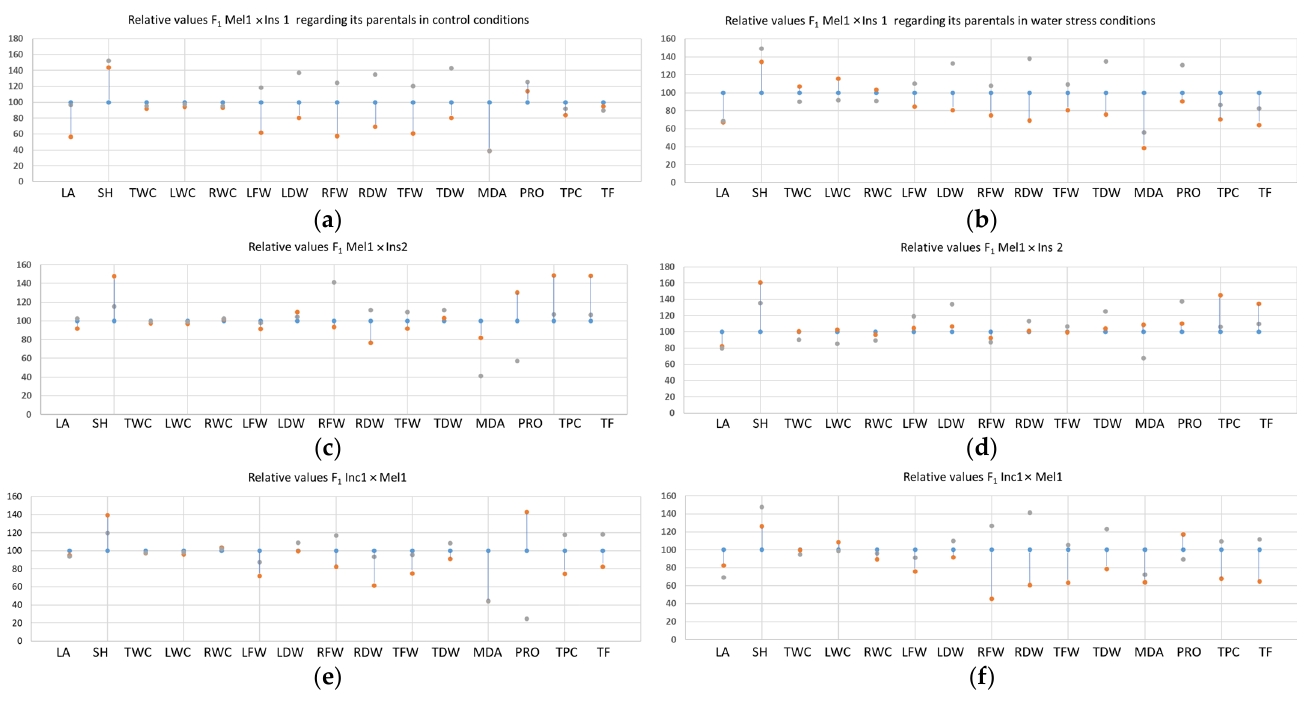
Figure 4. F1 relative values of MEL1 × INS1 in control ( a ) and under water stress ( b ); MEL1 × INS2 in control ( c ) and under water stress ( d ); INC1 × MEL1 in control ( e ) and under water stress ( f ). For each parameter, the MEL1 value was taken as a reference (100%), and the other values were referred to it. To clearly visualise superdominant or transgressive effects, a blue line has been drawn connecting the two parents. Abbreviations: leaf area (LA), stem height (SH), total water content (TWC), leaf water content (LWC), root water content (RWC), leaf fresh weight (LFW), leaf dry weight (LDW); root fresh weight (RFW), root dry weight (RDW), total fresh weight (TFW), total dry weight (TDW), foliar malondialdehyde (MDA), foliar proline (PRO), total foliar phenolic compounds (TPC), total foliar flavonoids (TF). Grey circles were used for hybrids, orange for the wild relatives and blue for the cultivated eggplant MEL1.